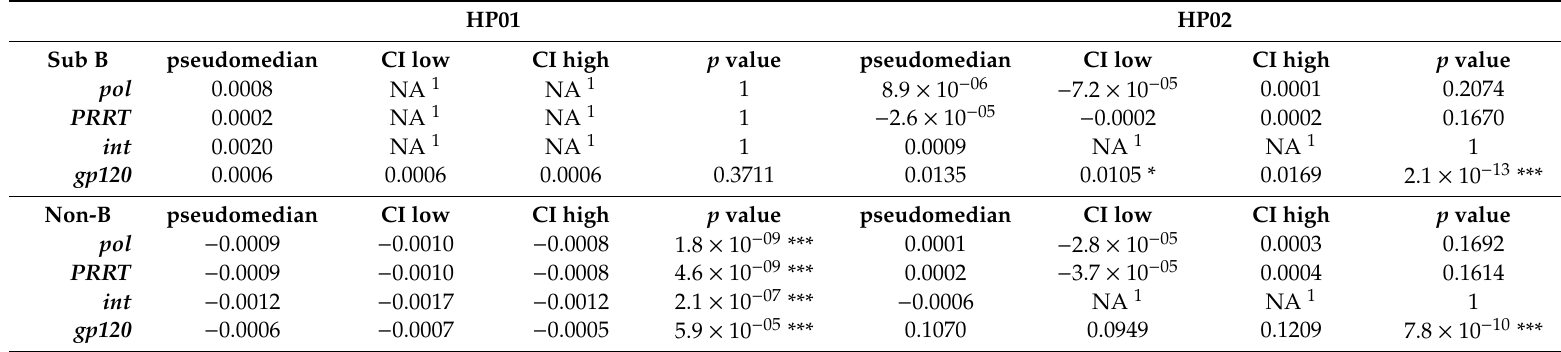
Table A3. Wilcoxon signed-rank comparisons of the adjusted genetic p-distance from HXB2, the HIV reference sequence, between the initial and final consensus sequences constructed in the HAPHPIPE pipelines for the simulation